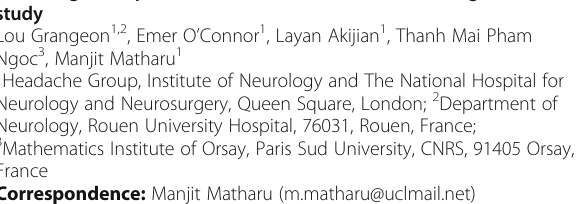
Table 1 (abstract P34). Characteristics of PTCH according to multivariate logistic regression model